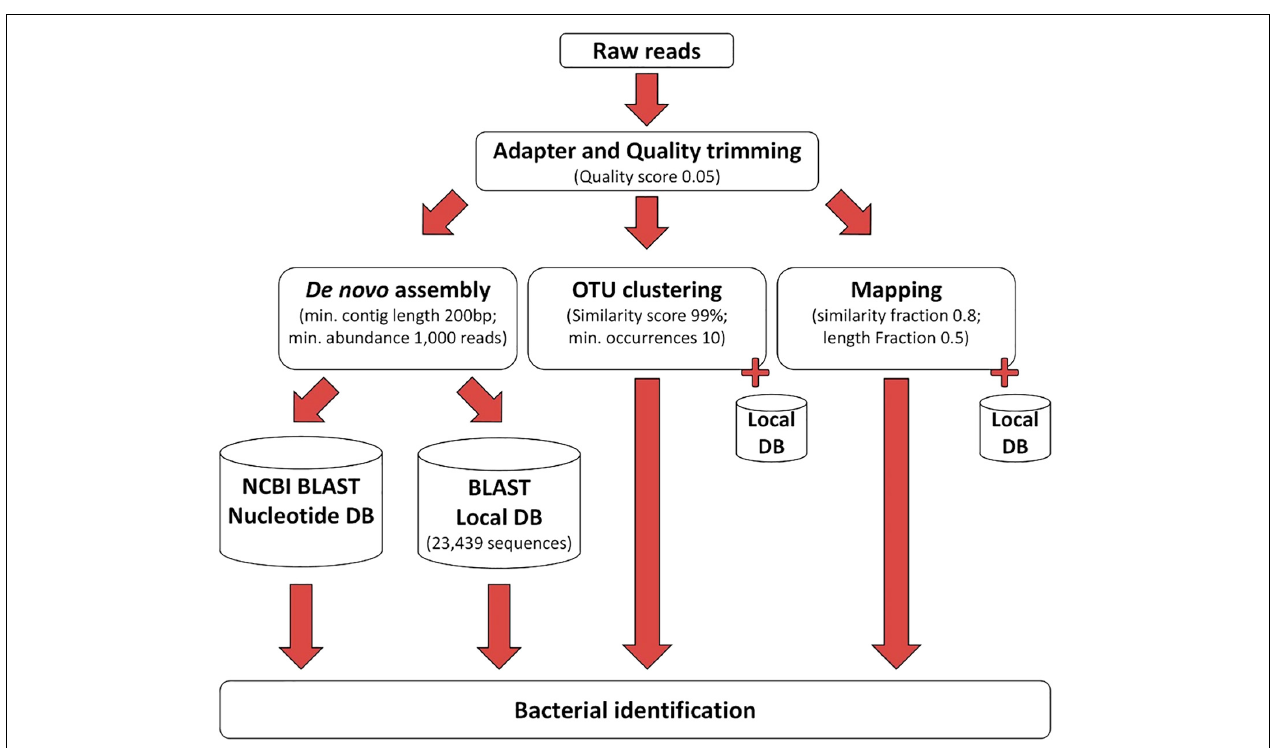
FIGURE 2 | The workflow used for processing of the NGS